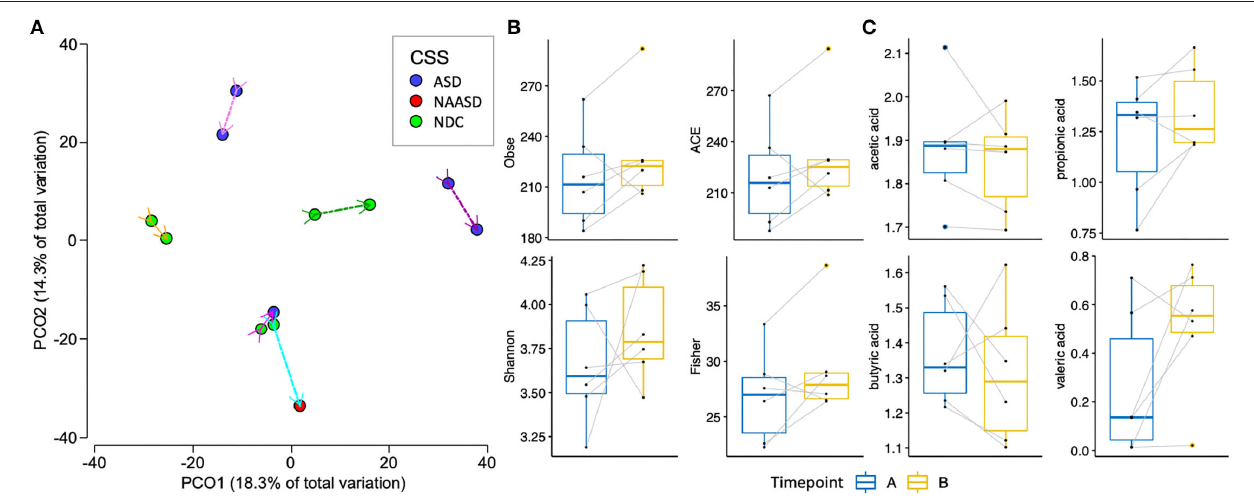
Positive fold changes are enriched in NDC, and negative fold changes are enriched in ASD or NAASD groups.